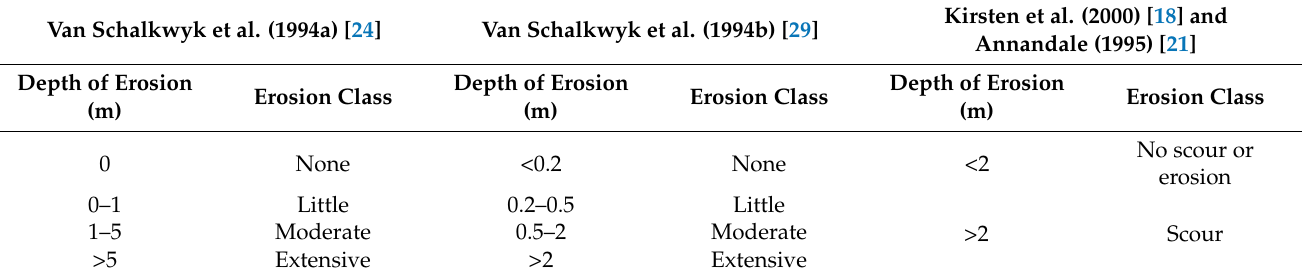
Table 1. Classification of the erosion